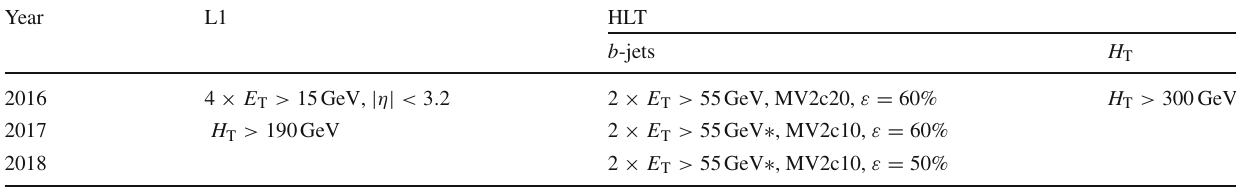
Table 6 Details, by year, of the lowest-threshold unprescaled triggers giving a two- b -jet plus H T signature. The minimum ( b -)jet E T , | η | , and b -tagging requirements are specified for each item. HLT b -jets are required to be within | η | < 2 . 5. E T thresholds denoted ∗ indicate that